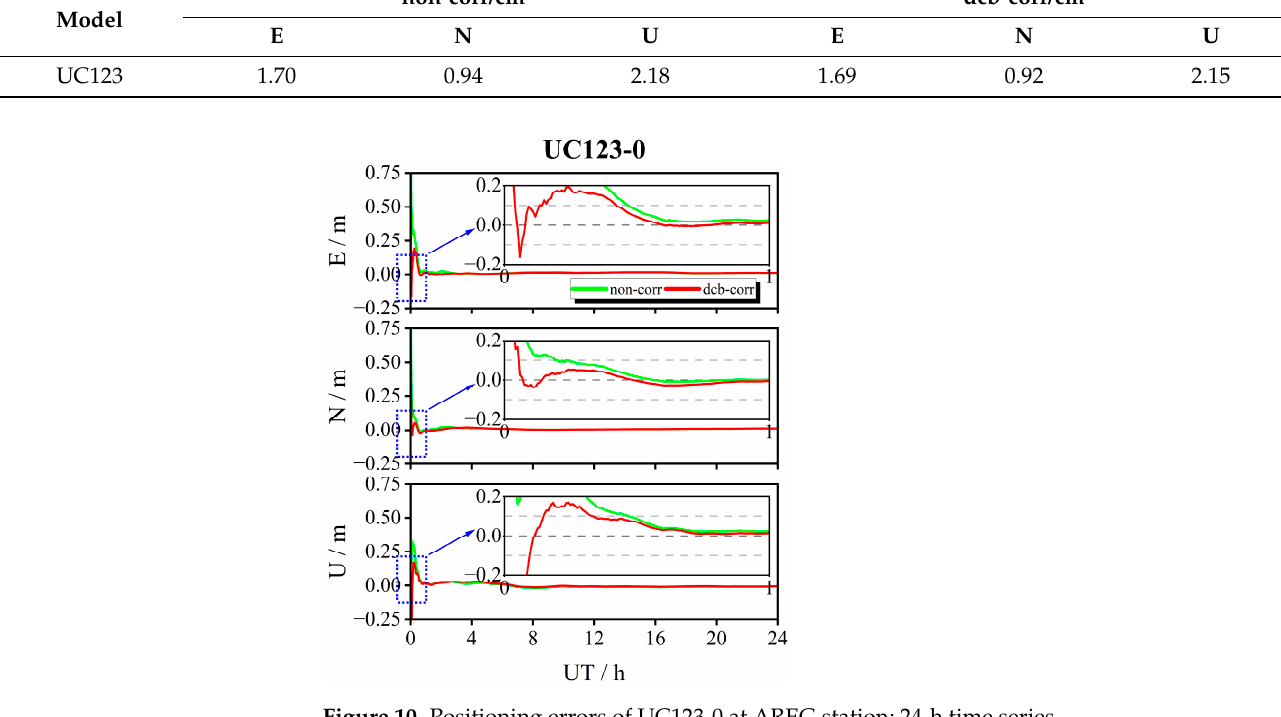
Table 7. Average positioning accuracy of PPP for UC123 model.